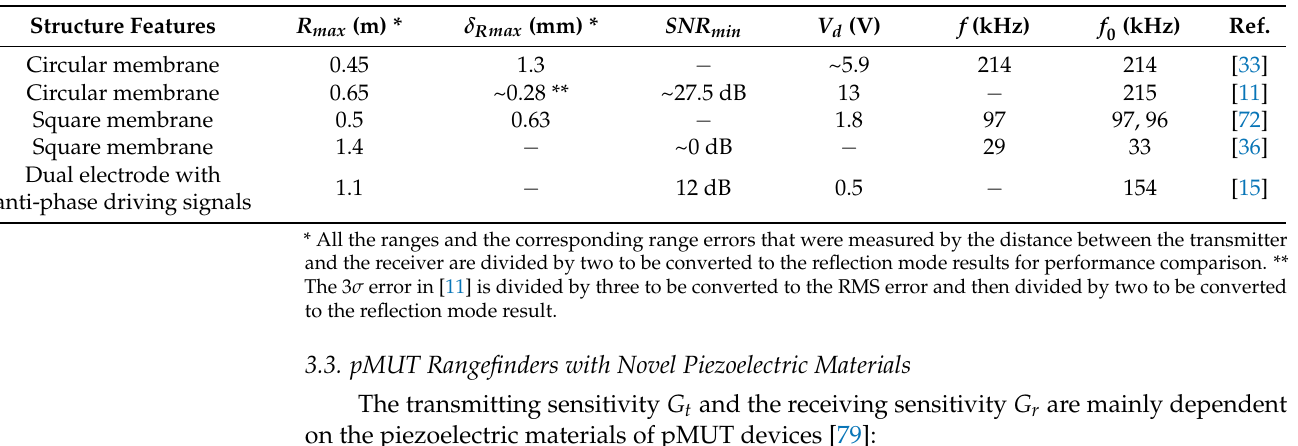
and single electrode modes. Reproduced with permission from [15] , Copyright 2017, Elsevier B.V.